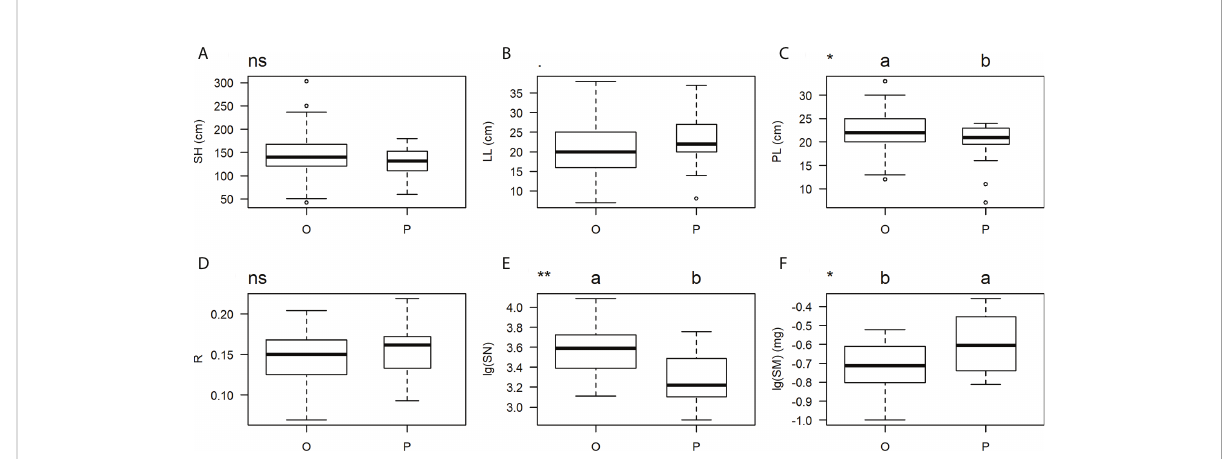
FIGURE 6 Plant functional trait comparisons ( A , shoot height; B , leaf length; C , panicle length; D , reproductive allocation, i.e., the ratio of panicle length to shoot height; E , log-transformed seed number per panicle; F , log-transformed mass per seed) between lineage O and P of Phragmites australis . Different letters represent signi fi cant differences. In the box diagram, the middle horizontal line is the median, and the box frame is the interquartile distance ( IQR ). Each whisker extends to the furthest data point in each wing that is within 1.5 times the IQR , data points further than 1.5 IQR are marked with a dot. ns represents no signi fi cance; · P < 0.1; * P < 0.05; ** P <